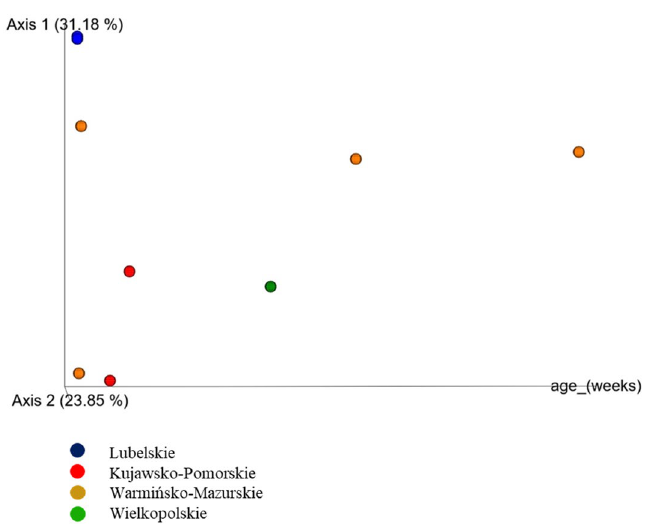
Figure 4. PCoA graph showing clustering by bacterial community composition in tracheal swabs from turkeys of different ages according geographical